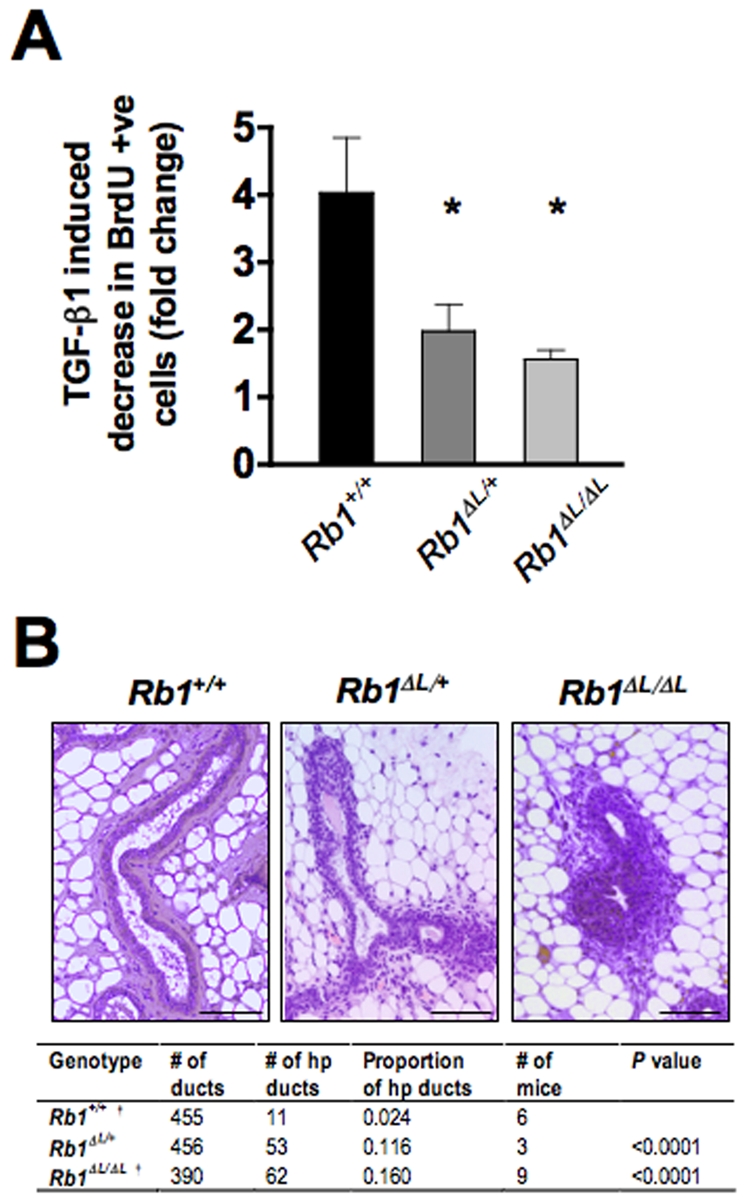
Defective TGF-β proliferative control in Rb1ΔL/ΔL and Rb1ΔL/
+ mice.A) Rb1+/+, Rb1ΔL/+, and Rb1ΔL/ΔL mammary epithelial cells were treated with TGF-β1 and pulse labeled with BrdU 24 hrs later. The percentage of cells incorporating BrdU was measured by immunofluorescence microscopy. The fold decrease in proliferation between treated and untreated parallel cultures was determined and the average of three independent experiments is shown. * indicates a statistically significant difference (Student's t test; P<0.05). Error bars indicate one standard deviation from the mean. B) H&E staining of paraffin sections of Rb1+/+, Rb1ΔL/+, and Rb1ΔL/ΔL mammary tissue from 8 week old mice. Each image displays a representative cross section of ducts. The table below displays the proportion of hyperplastic (hp) ducts found in Rb1+/+, Rb1ΔL/+, and Rb1ΔL/ΔL mammary glands. Proportions were compared between genotypes using a chi-square test. Scale: 100 µm. † denotes previously published data that has been provided for comparison purposes.